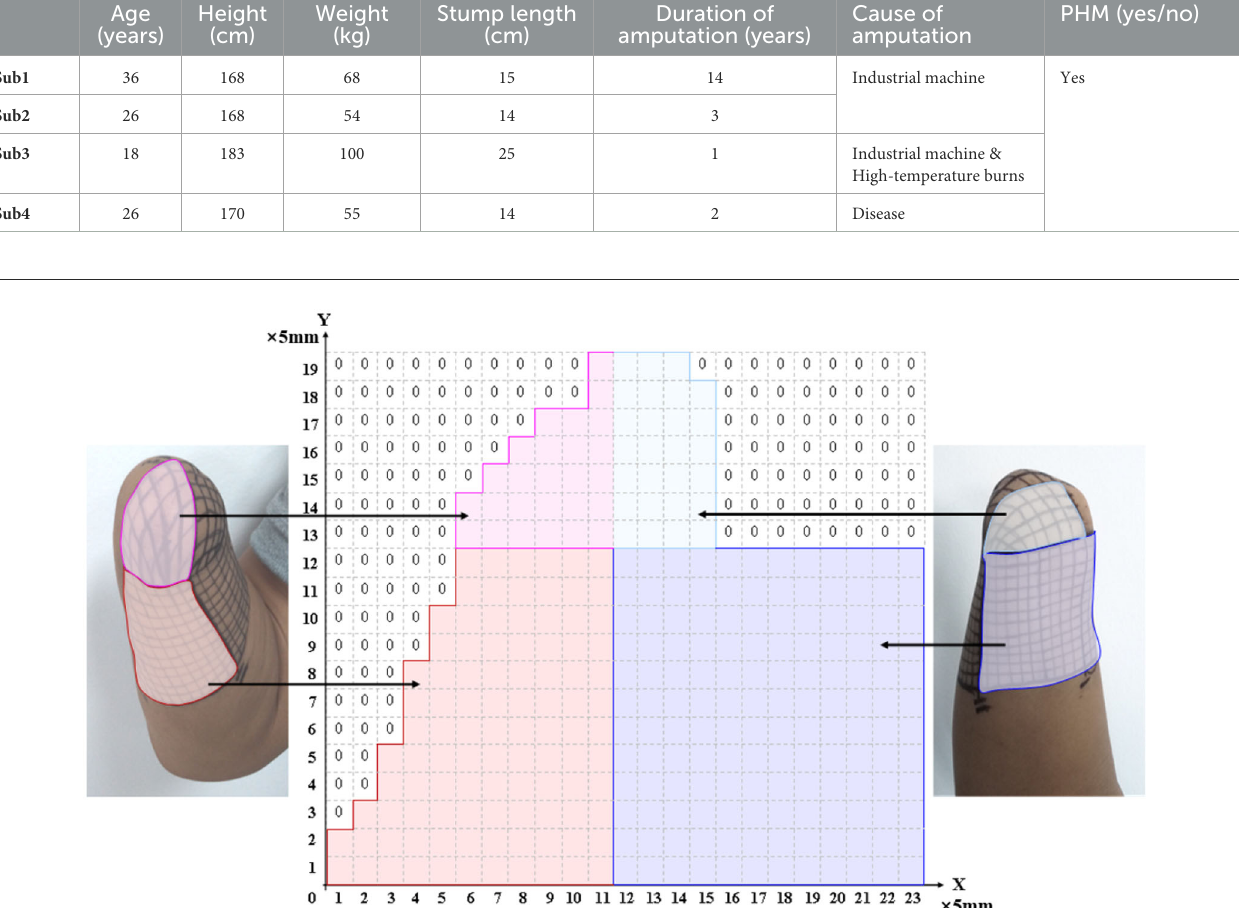
FIGURE1 The relationship between the meshed coordinate and the skin region of PHMs.